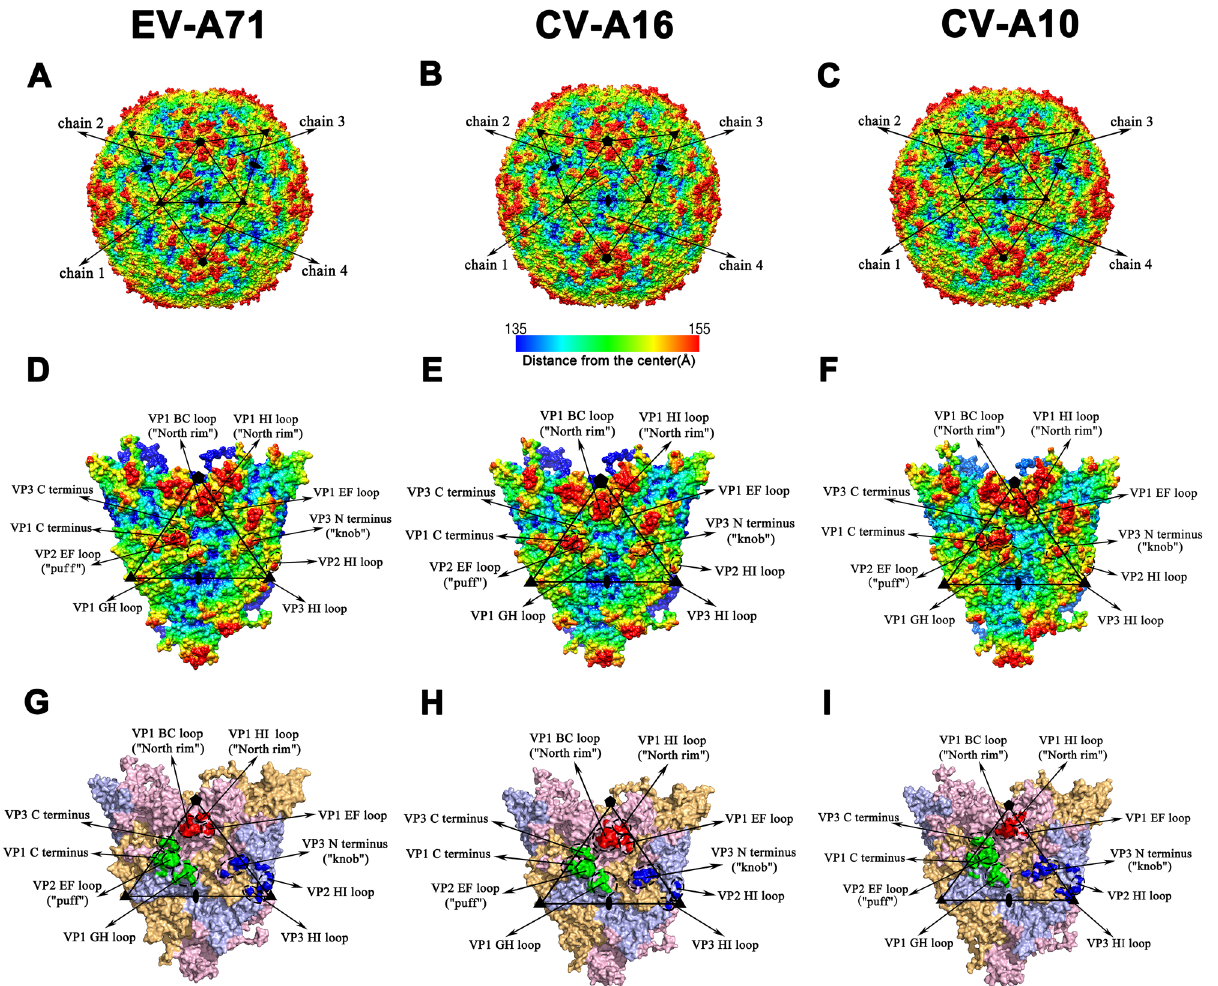
Figure 1. Capsid structures of EV-A71, CV-A16 and CV-A10. ( A–C ) Radius-colored surface representations of EV-A71 ( A ), CV-A16 ( B ) and CV-A10 ( C ). Capsids are colored according to their radius from blue to red as shown in the color bar. The multiple chains consisting of four units labeled as chain 1–4 are indicated by black triangles. Fivefold, threefold and twofold vertexes are marked as pentagons, triangles and ovals, respectively. ( D–F ) Zoom-in views of multiple chains and capsid characteristics of EV-A71 ( D ), CV-A16 ( E ) and CV-A10 ( F ). The color scheme is as described in the legend to ( A–C ). The central chain (chain 1) is outlined by a black triangle. ( G–I ) The predicted conformational epitopes on the chain 1 of EV-A71 ( G ), CV-A16 ( H ) and CV-A10 ( I ). The prediction results of conformational epitopes for CV-A10 are obtained from our previous work with permission from the journal 44 . Structural proteins VP1-3 are shown as surface representations in light pink, light blue and light orange, respectively. The chain 1 is outlined as the ( D – F ). The conformational epitopes clustered into three sites are highlighted in red (site 1), green (site 2) and blue (site 3),